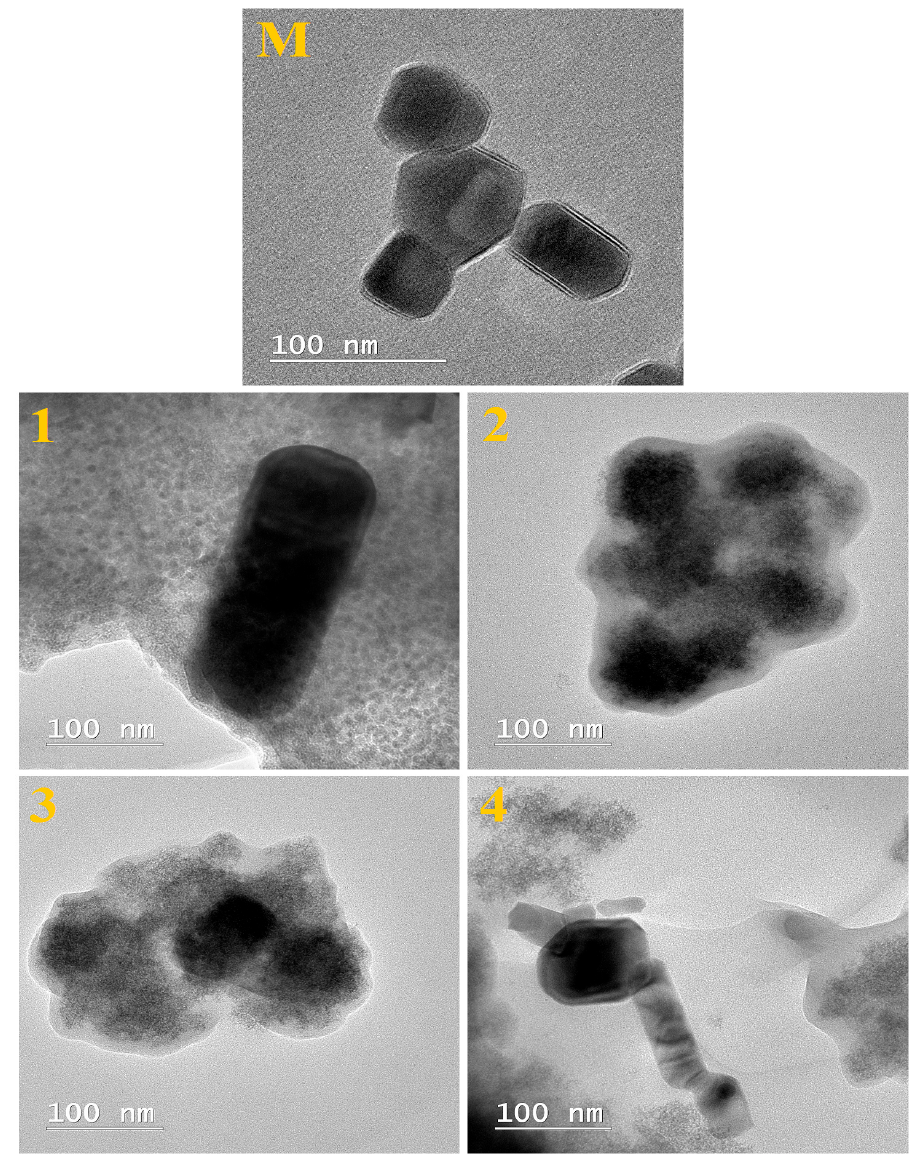
Figure 4. TEM images of unfunctionalized ZnO nanoparticles (M) and of ZnO nanoparticles modified with (1) GPTMS, (2) PhTES, (3) OTES, and (4) ODTES, respectively. Table 1. Thermal degradation of unfunctionalized ZnO (M) and of dried ZnO materials modified with different silane precursors.